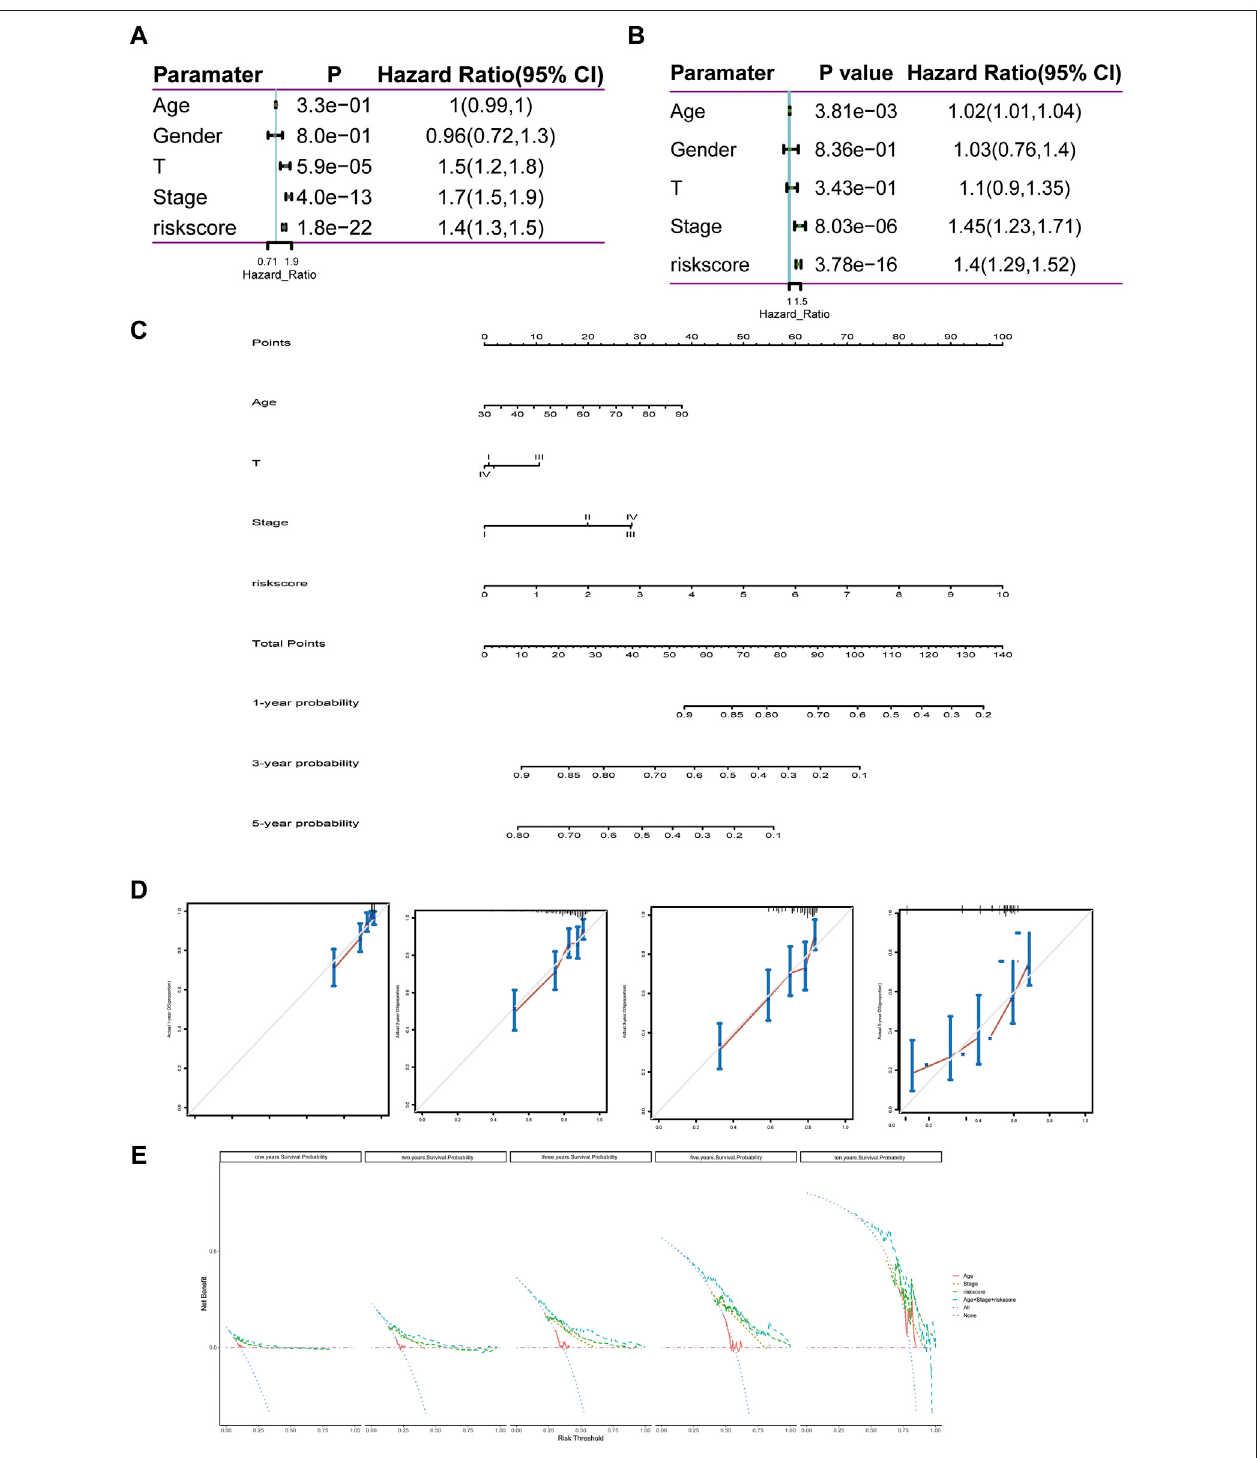
FIGURE 8 | Construction and evaluation of the nomogram predicting the OS for TCGA-LUAD patients. (A,B) Univariate and multivariate regression analyses of clinical parameters. (C) Nomogram for predicting 1-, 3-, and 5-year OS of LUAD patients based on four independent prognostic factors. (D) One-, 2-, 3-, and 5-year calibrationcurvesofTCGA-LUAD. (E) One-,2-,3-,5-,and10-yeardecisioncurveanalysisofTCGA-LUAD.Comprehensiveanalysisoftranscription,mutation,andcopy number variation among 11 lipid metabolism-related genes.